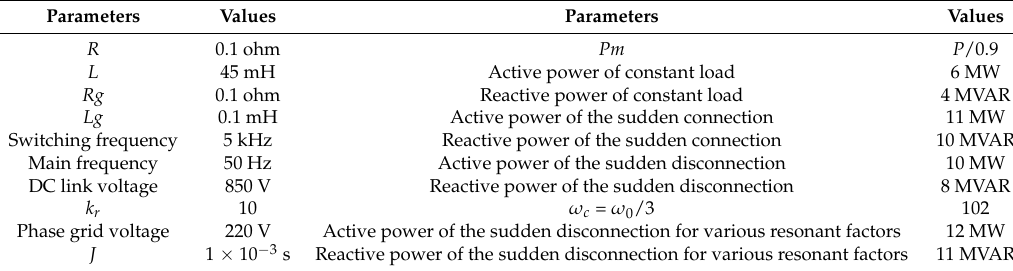
Figure 3 . The Nyquist diagram of Δ i d for constant values of: ( a ) Δ P m ; ( b ) Δ P ; ( c ) Δ v gd .